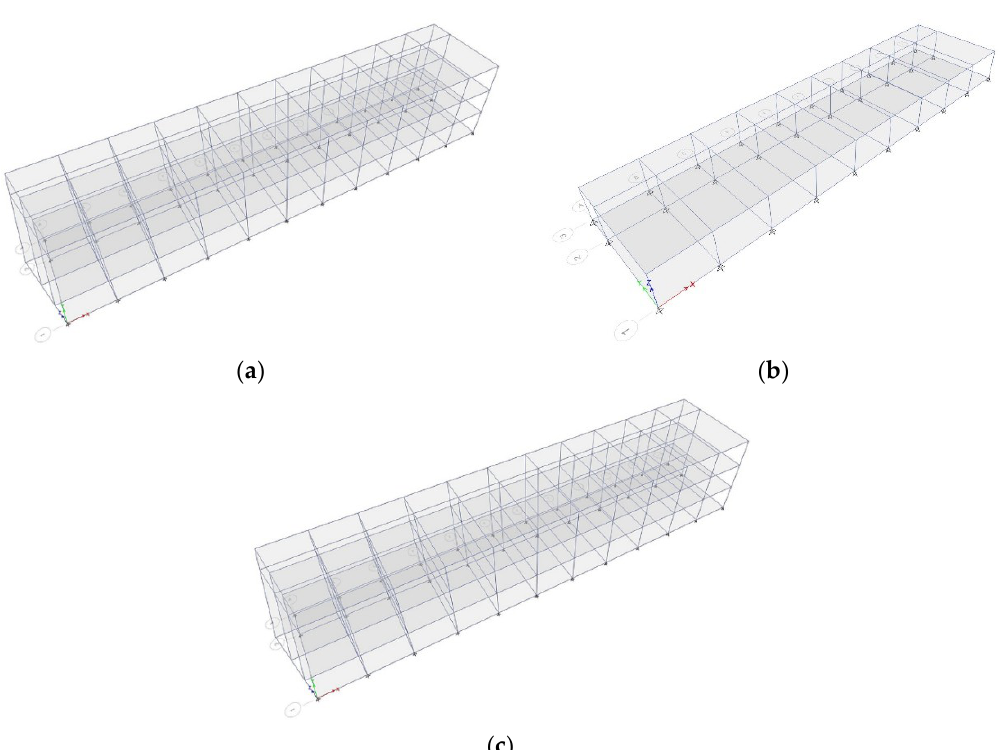
Figure 2. The 3D model of the analysis structure: ( a ) Type 1, ( b ) Type 2, and ( c ) Type 3. Five analysis models were prepared for each type by applying the hysteresis models to beam and column members differently for the three types of analysis structures, as shown in Table 2. In a preceding study [25] on a two-dimensional frame under quasi-static cyclic loading, the pivot model most closely expressed the experimentally observed be- havior. Additional comparative analyses on the single-story Oh’s frame [26] and two- story Lee’s frame [27] in this study showed that the pivot model also predicted the exper- imental results well, as shown in Figure 3. The P.P., which applied a pivot model involv- ing beams and columns, was set as the reference analysis model in this study based on these findings. Accordingly, the analysis models changed to concrete and Takeda models for columns were named P.C. and P.T., respectively, and those changed to concrete and Takeda models for beams were named C.P. and T.P., respectively. Table 2. Description of the analysis models considered by type. Analysis Model ( b ) Figure 3. Additional verification for setting a reference model: ( a ) Oh’s frame [26] and ( b ) Lee’s frame [27]. As the analysis model was a three-story low-rise building, NDA was performed us- ing three recorded ground motions with dominant acceleration in the short-period region: El Centro, Northridge, and Taft. Prior to the scaling of the selected ground motions, NSA was conducted for each type to pre-evaluate the overall characteristics of the structure.